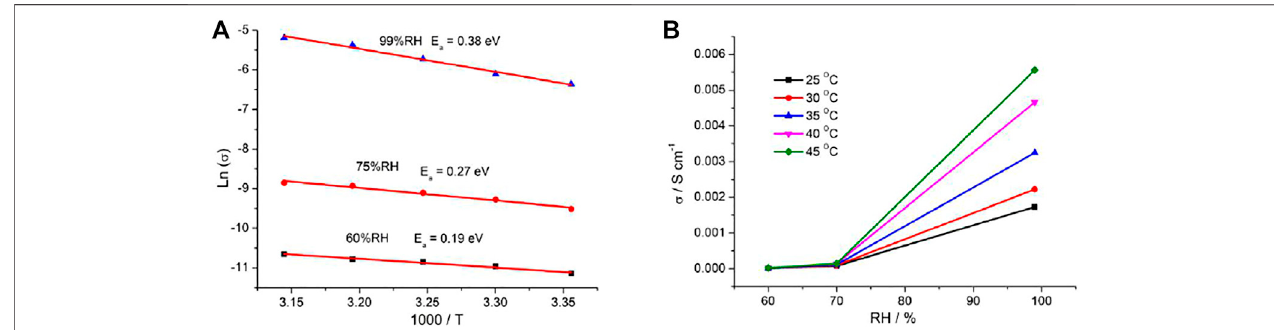
FIGURE 4 | (A) Plots of ln( σ ) vs. 1000/ T at selected RH and (B) plots of σ vs. RH at the selected temperatures for 1 .